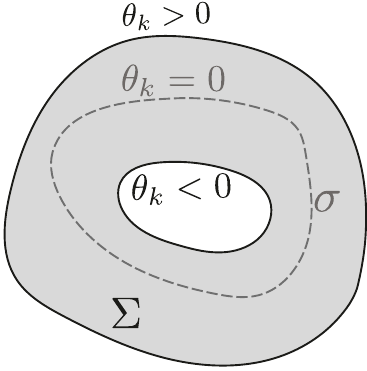
Figure 10 . Illustration of a compact spacelike hypersurface Σ with an inner boundary that is outer trapped and an outer boundary that is outer untrapped. By Theorem 2 a marginally outer trapped surface σ in Σ is guaranteed to